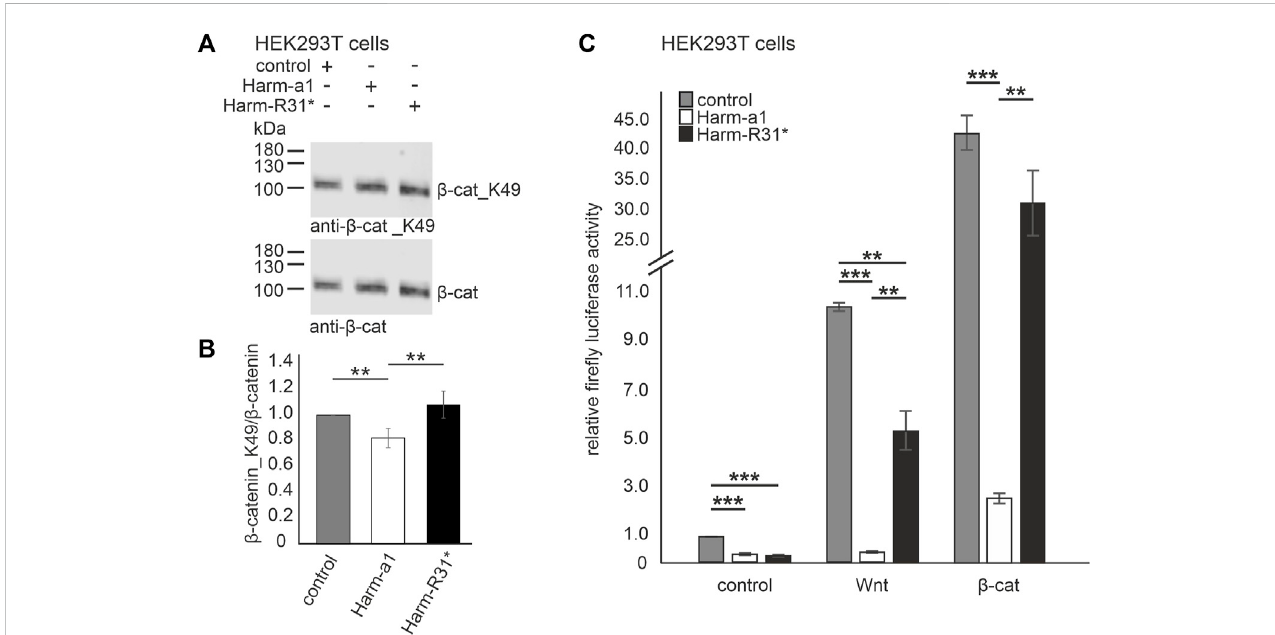
FIGURE 3 Harmonin overexpression leads to the decrease in Wnt signaling activity (A) Representative Western blot analysis of β -catenin ( β -cat) expression in HEK293T cells transfected with harmonin a1-GFP (Harm-a1), truncated harmonin a1_R31*-GFP (Harm-R31*), or GFP (control) and β -catenin ( β -cat). (B) Quanti fi cation reveals that the expression of full length harmonin a1 signi fi cantly decreases β -cat_K49/ β -cat ratio ( − 0.2) while the expression of truncated harmonin a1-R31* did not alter the β -cat_K49/ β -cat ratio when compared to control transfected HEK293T cells; 12% polyacrylamide gel. Two-tailed Student ’ s t -test, ** p ≤ 0.01; N = 5 experiments. (C) Wnt response in transfected HEK293T cells measured by TCF/LEF luciferase activity assay. In unstimulated condition (control, left) luciferase activity is signi fi cantly decreased in Harm-a1 and Harm-R31* transfected cells compared to empty vector control. Stimulation with Wnt conditioned medium leads to an increase in luciferase activity for all, whereby control as well as Harm-R31* show signi fi cantly more cWnt signaling activity than Harm-a1 (Wnt, middle). Addition of β -cat results in the highest Wnt activity and reveals the largest difference of luciferase